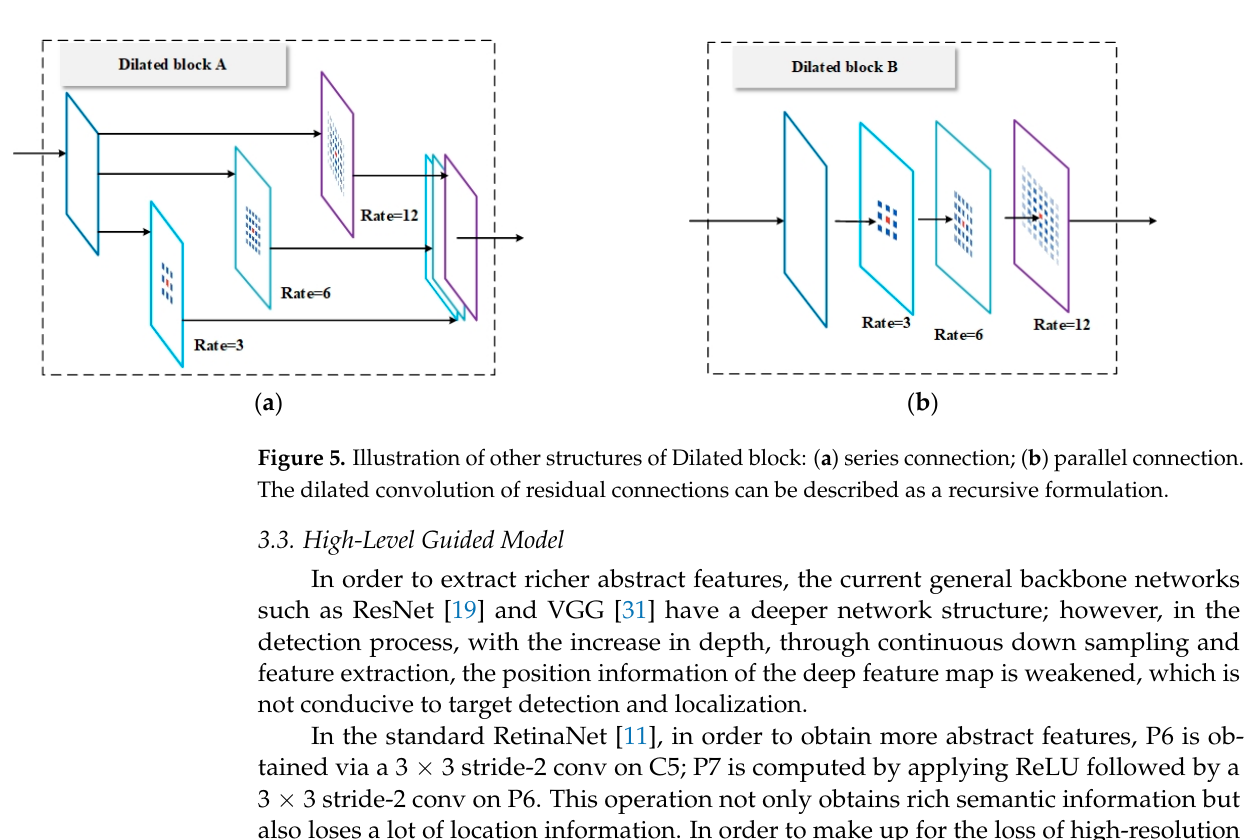
ture. The symbol ⊕ denotes feature fusion by addition. represents a dilated